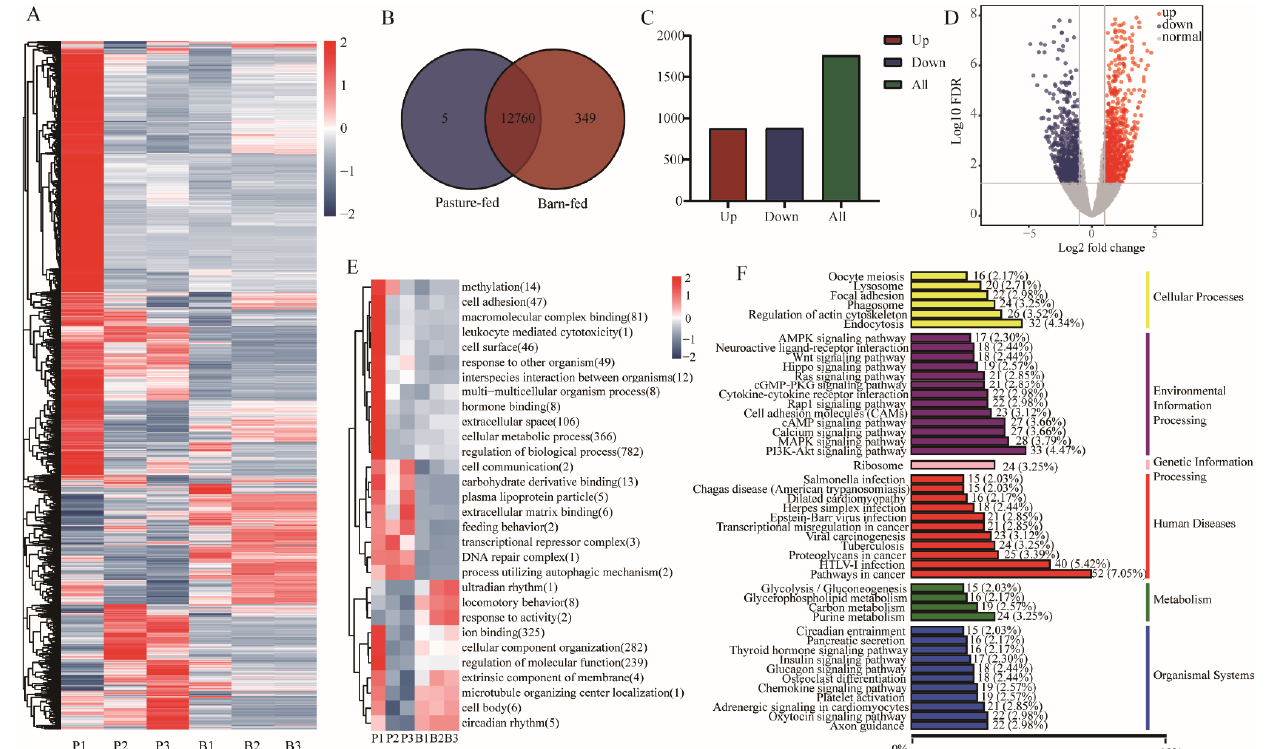
Figure 2. mRNA analysis of muscles from pasture-fed and barn-fed black goats. ( A ) Hierarchical cluster analysis of genes identified in the pasture-fed and barn-fed group. ( B ) Number of genes expressed in the two groups. ( C ) Number of differentially expressed genes. ( D ) Distribution of the genes expressed in the two groups, red dots and blue dots indicate genes significantly up-regulated or down-regulated in the barn-fed group. ( E ) GO Enrichment analysis of the differentially expressed genes. ( F ) KEGG analysis of the differentially expressed genes.